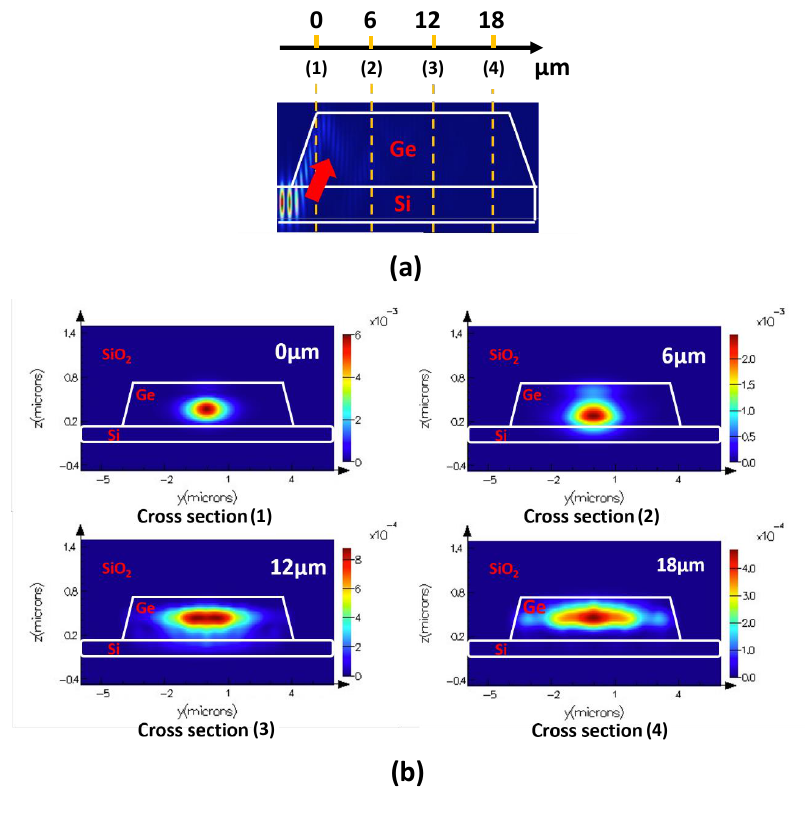
Figure 4. ( a ) Simulated optical absorption at 1550 nm within the proposed photoconductive switch. ( b ) Simulated 1550 nm optical mode distributions at different propagation distances within the proposed photoconductive